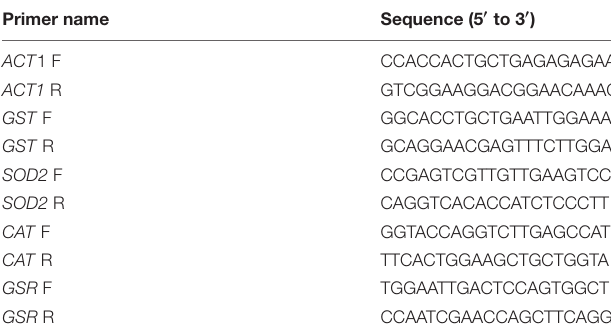
TABLE 1 | Sequences of primers for RT-qPCR amplification of key copper-tolerant genes. Primer